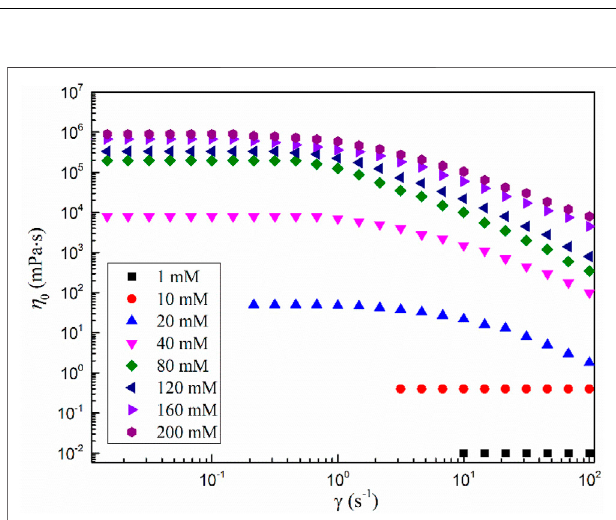
FIGURE 3 | Shear viscosity versus shear rate curves of the MSA/CTAB